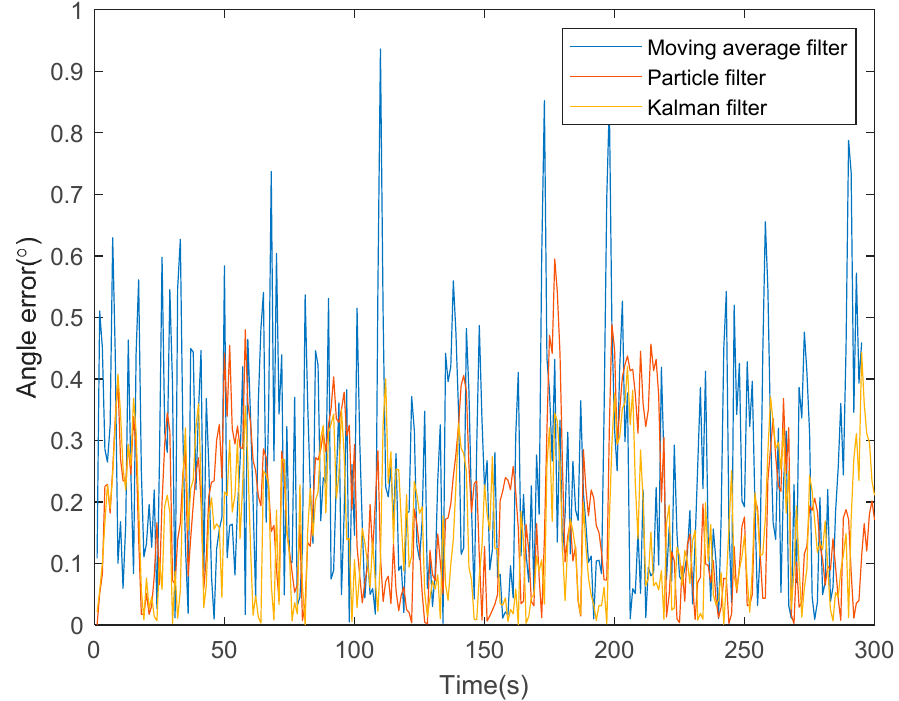
Figure 7. Filtering error of the attitude angle of the sowing monomer.